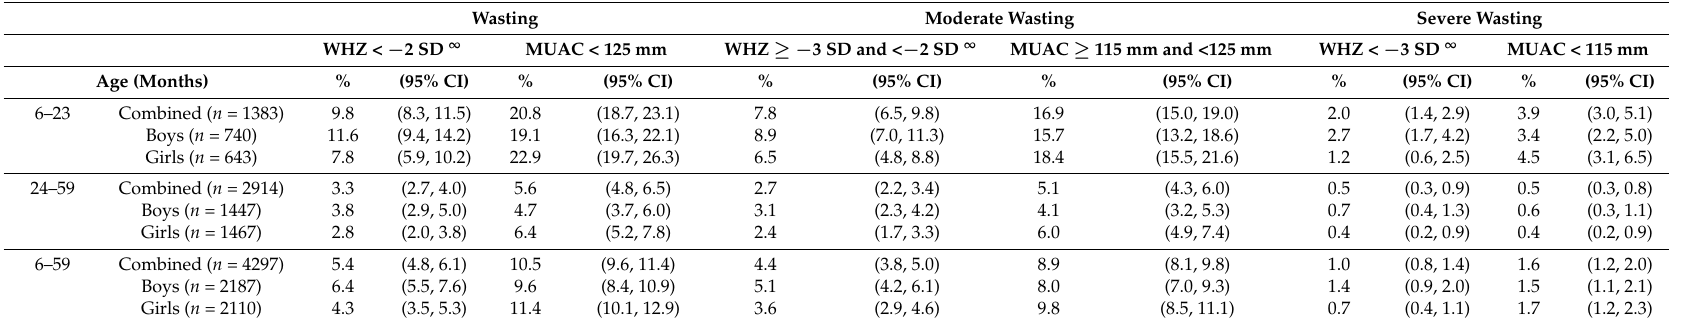
Table 2. Prevalence of wasting as measured by weight-for-height Z -score (WHZ) and mid-upper arm circumference (MUAC) among 6–59 month children in rural south